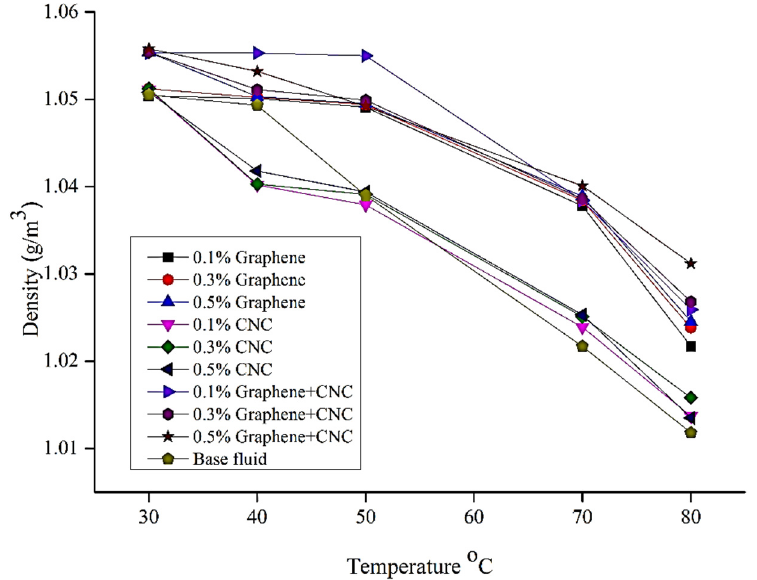
Figure 17. Nanofluids and hybrid nanofluids density measurement at varying temperatures (graphene, CNC, and hybrid (graphene+CNC)).